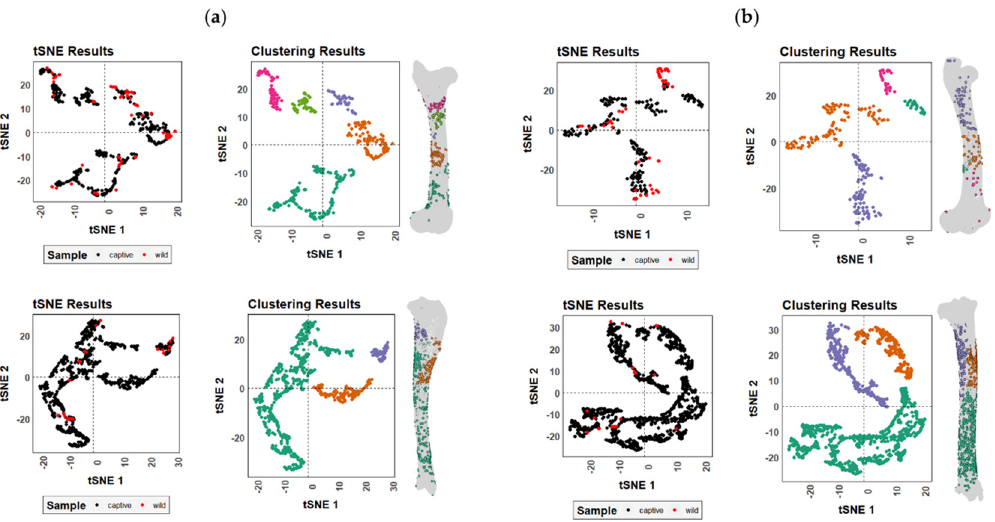
Figure 7. t-SNE scatter plots for both tooth marks on the ( a ) left and ( b ) right femora and tibiae modified by captive and wild wolves. Different colors in the clustering results plots indicate clustering patterns identified by DBSCAN.